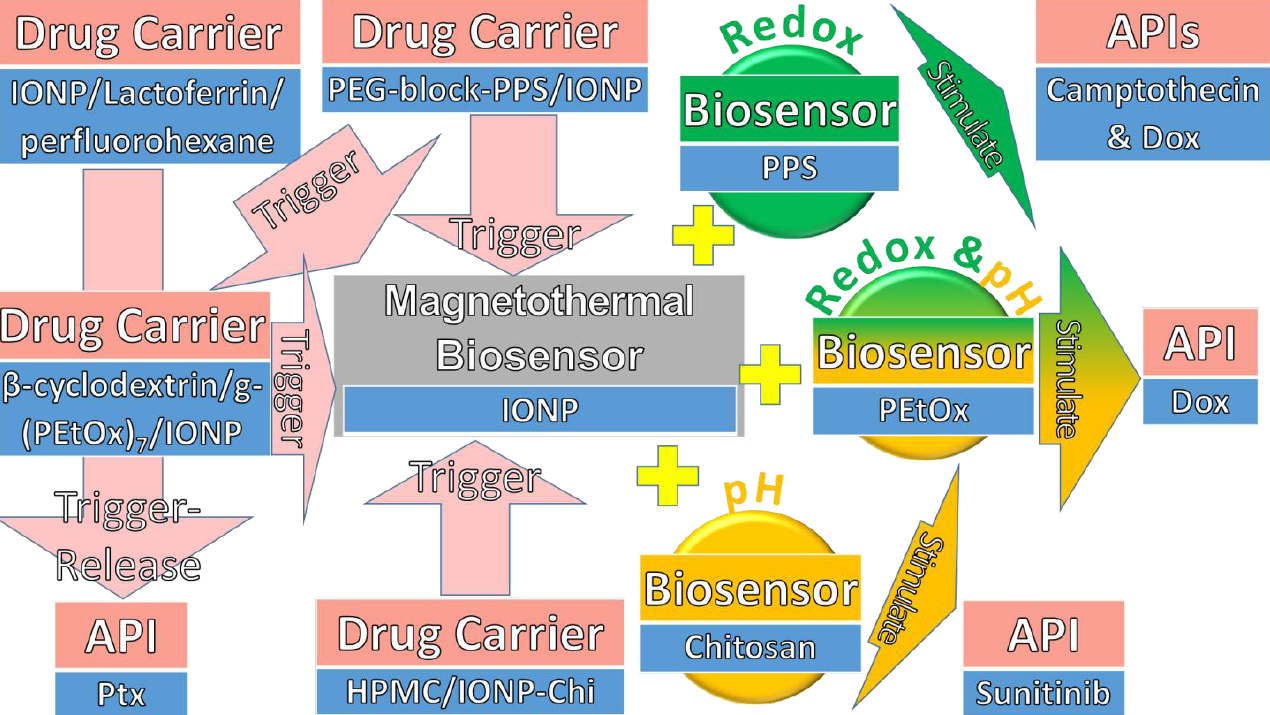
Figure 4. The magnetothermal triggers added with either redox, pH, or both stimuli into biosensors in drug carriers to release API.